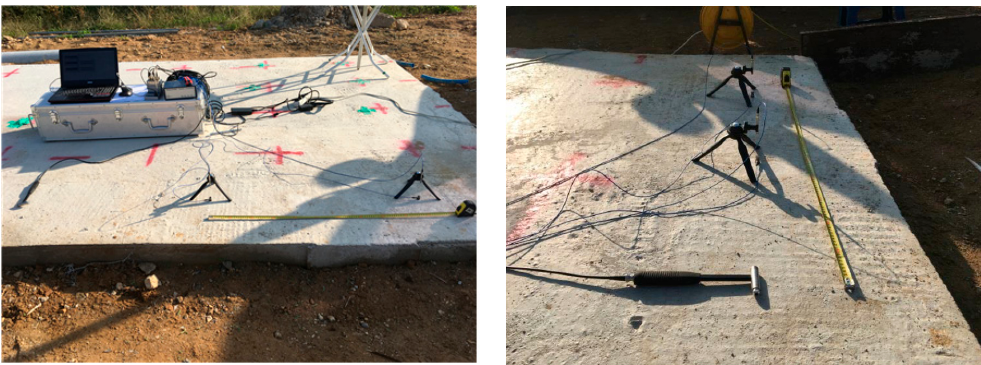
Figure 12. Field test setup with test system module on a model concrete slab.